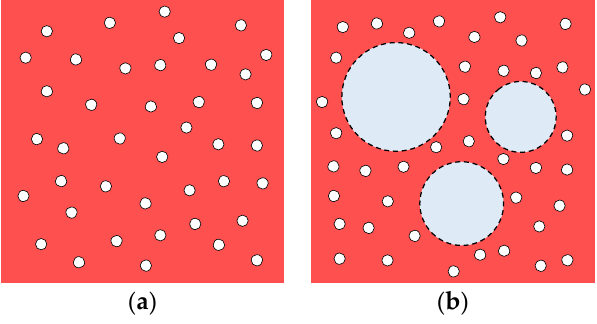
Figure 1. ( a ) Homogeneous and ( b ) bubble-structure (BS) dye-doped scattering media. The white circles in ( a ) and ( b ) and the blue dashed circles in ( b ) represent scattering particles and spacer particles (SPs), respectively.